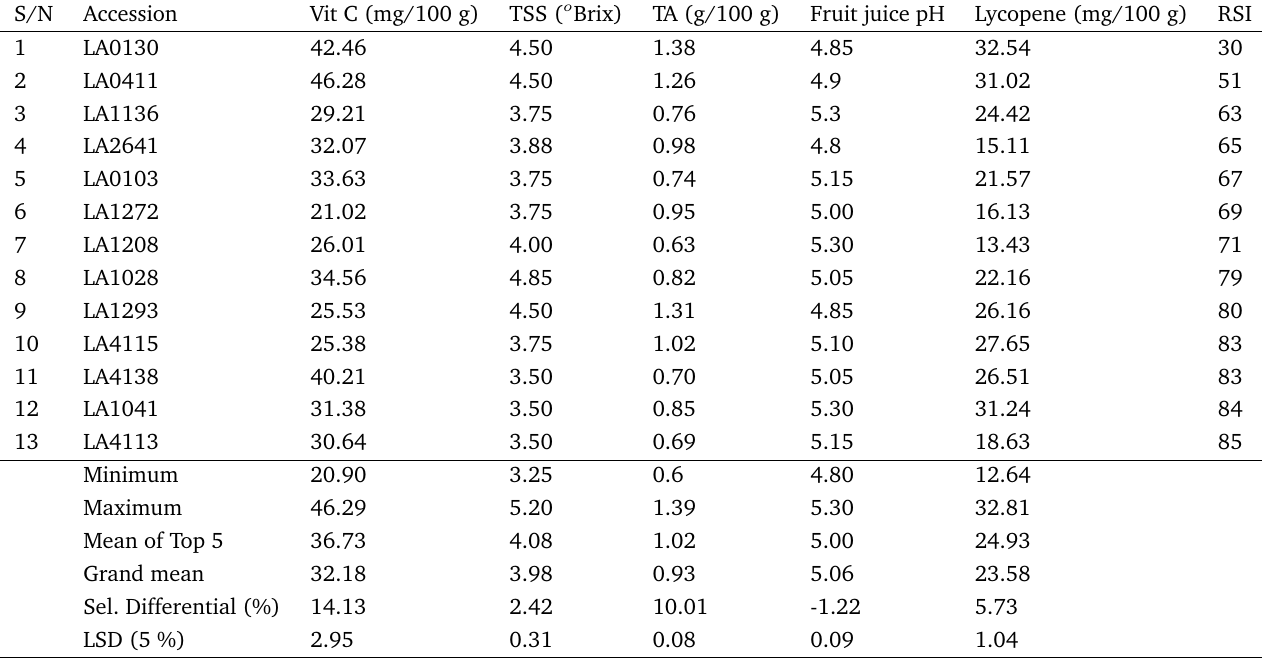
Table 4. Ranking of the mean performance of nutritional and physicochemical parameters of wild tomato accessions